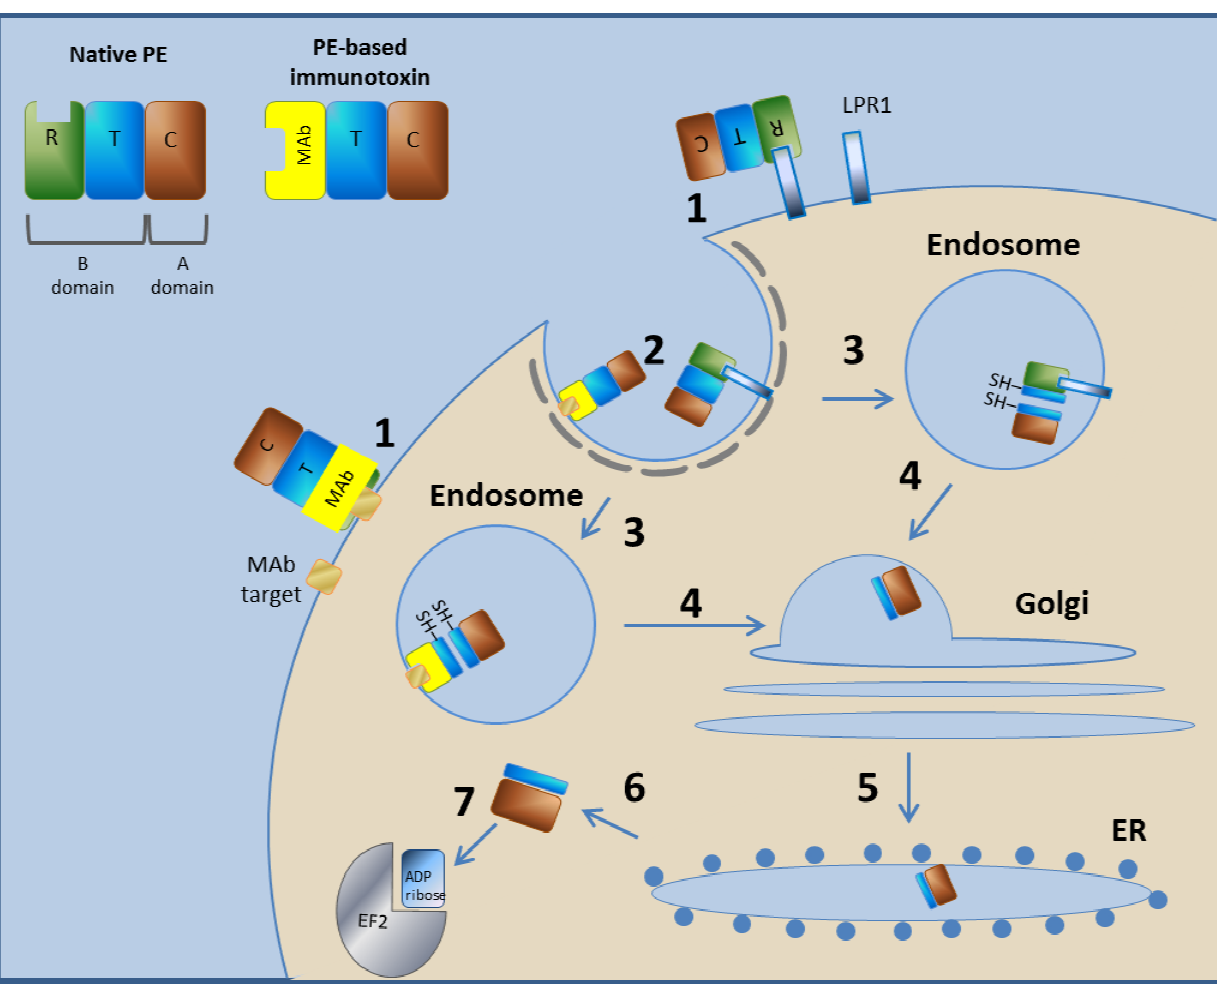
Figure 1. Mechanism of action of PE and PE-based immunotoxins. In step 1, the